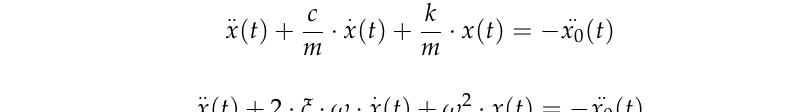
Figure 1. Kinematic scheme of a single-degree-of-freedom elastic system. After shifting the known term to the right part of Equation (1) and dividing both sides by m, we obtain